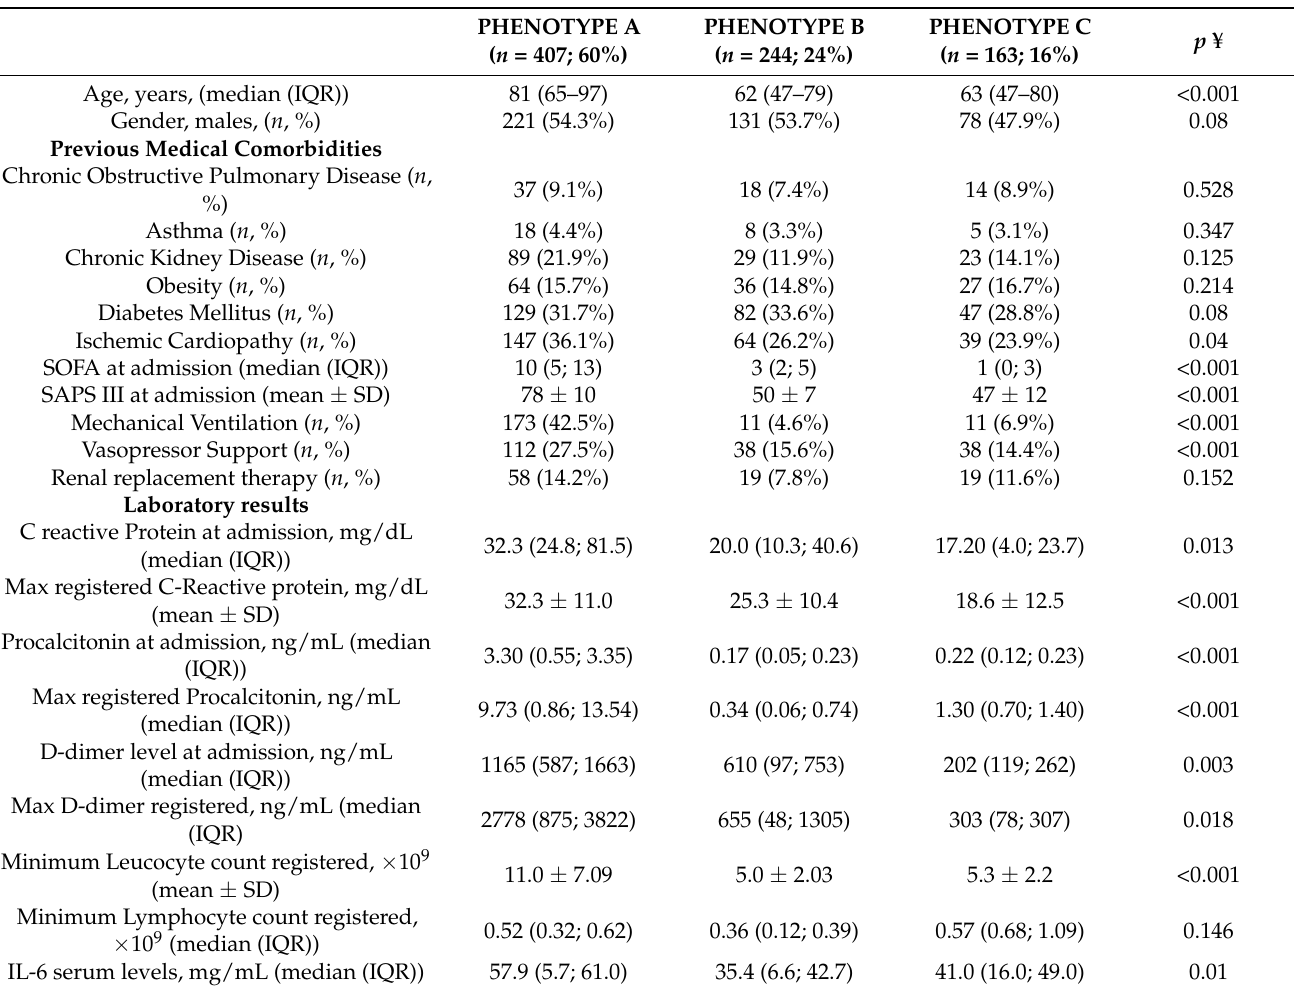
Table 1. Demographic, clinical and outcome variables of patients according to the COVID-19 phenotype